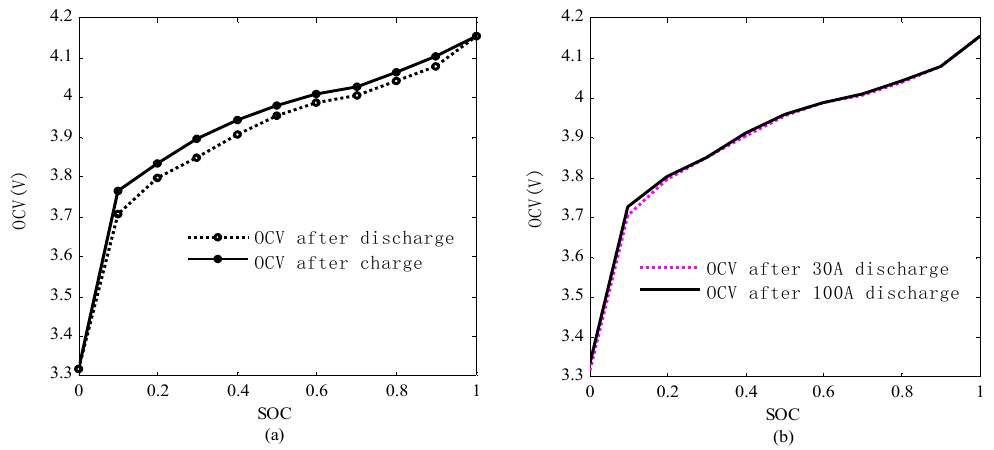
Figure 1. Open-circuit cell voltages as a function of SOC at room temperature.